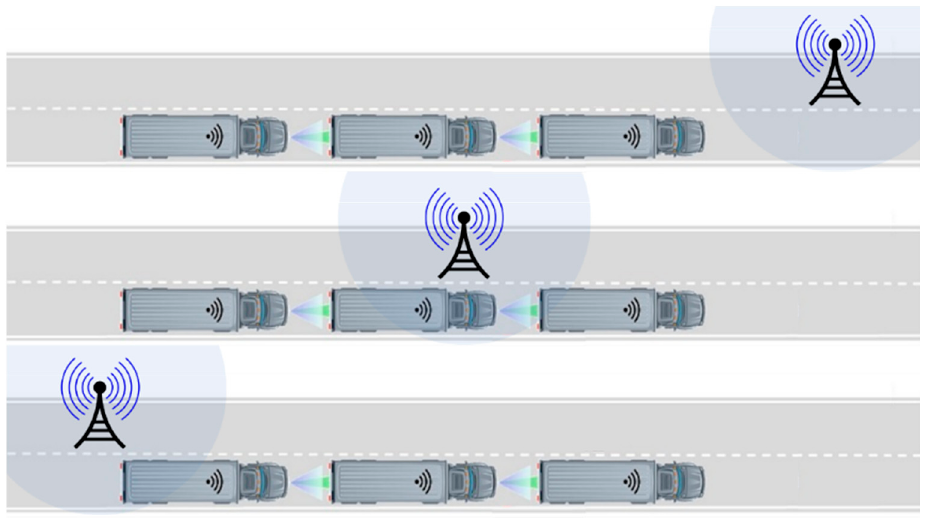
Figure 5. I2V interaction as used in ENSEMBLE multi ‐ brand platooning